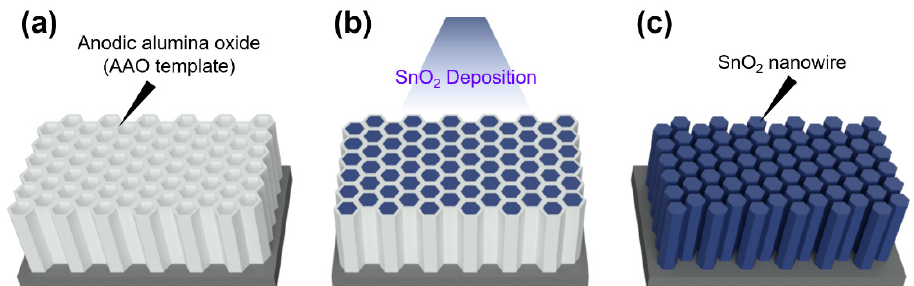
Figure 8. Schematic image of ( a ) the highly regular AAO template; ( b ) the template cross-section with nanowires deposited inside the nanopores; and ( c ) nanowires after removing the AAO template.